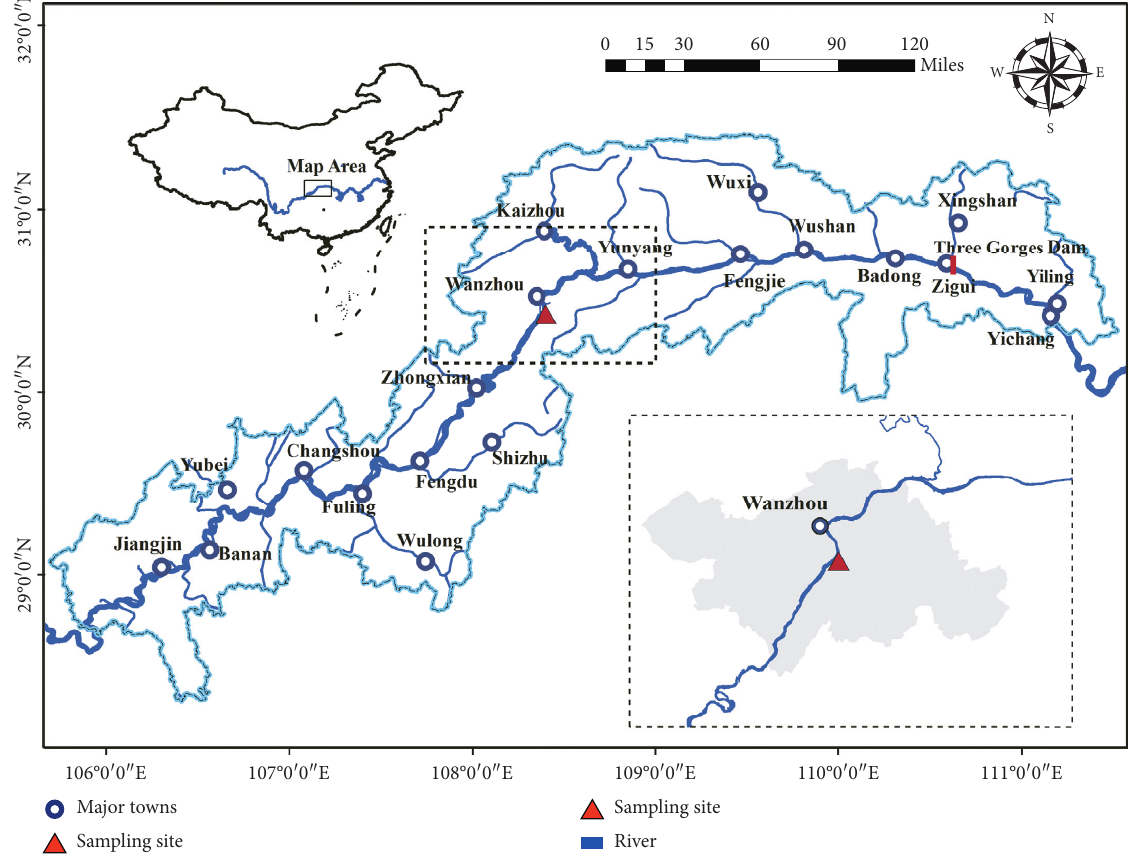
Figure 1: Location of the sampling site. Table 1: Physicochemical properties of the original WFLZ soil in the TGR